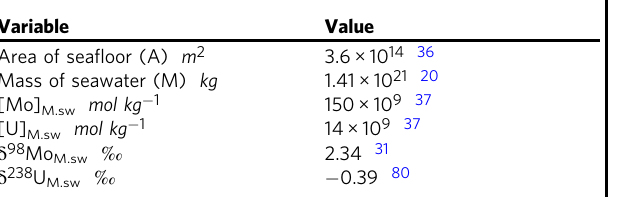
Table 2 Fixed values of modern oceanographic